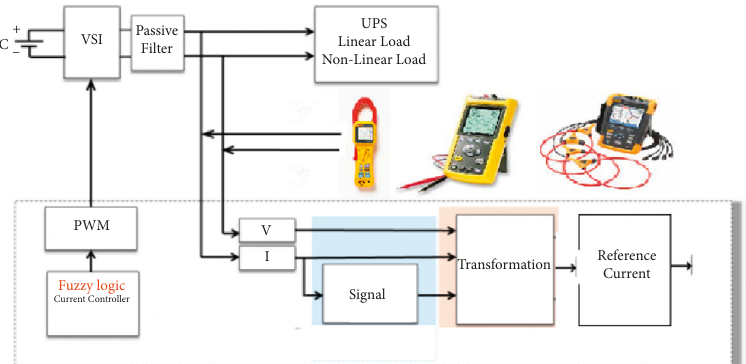
Figure 8: Experimental Setup, design, and development for harmonic analysis for UPS systems connected to linear & non-linear load.